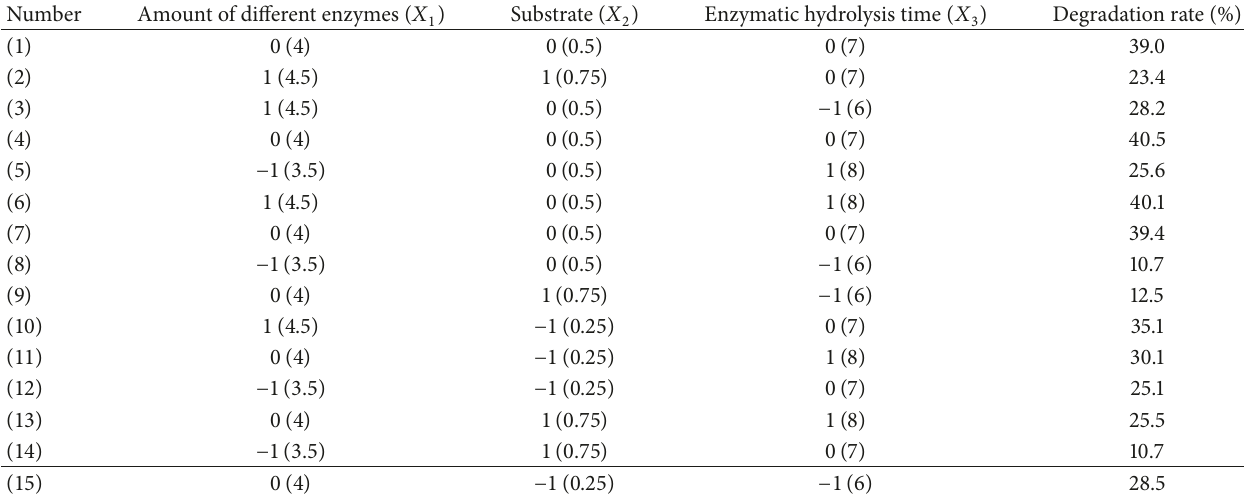
Table 3: Box-Behnken design and observed responses.